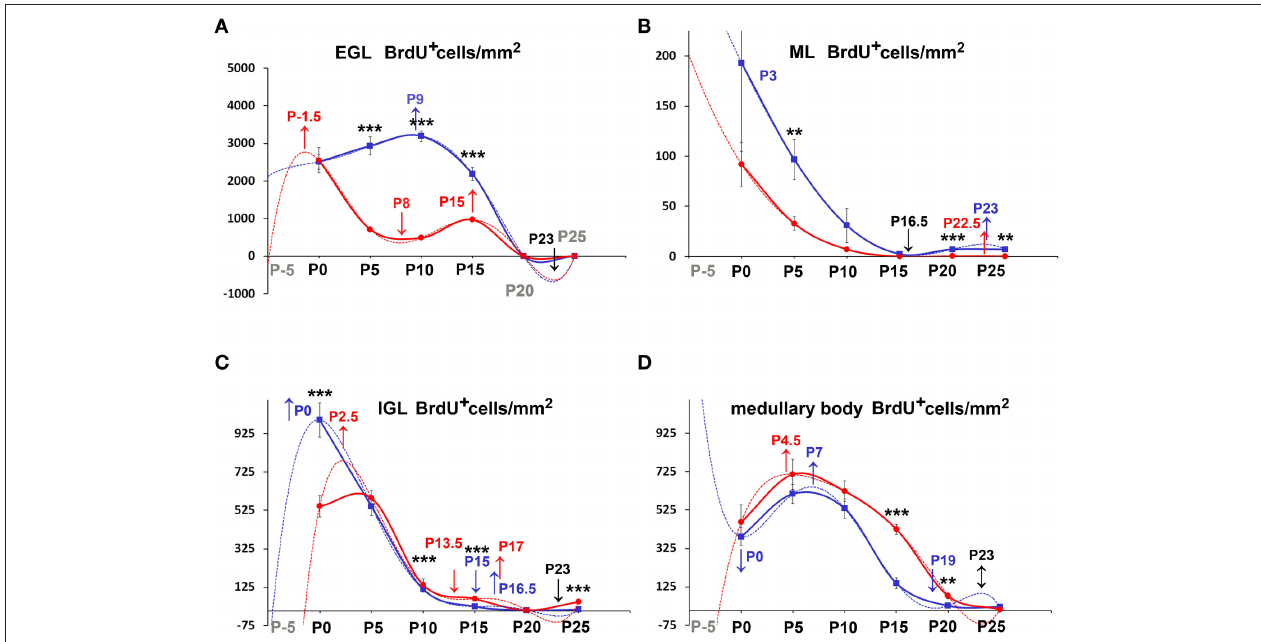
FIGURE 5 | Descriptive graphs (solid lines) and correlation curves (dashed lines) of normalized PrCDs. Graphs highlight the trends and differences across genotypes of normalized PrCD (BrdU + cells/mm 2 ) in the four cerebellar compartments defined in this study (EGL, ML, IGL, and medullary body). Postnatal ages corresponding to the minima and maxima of correlation curves are indicated with colored letters and upwards or downwards arrows. Blue and red lines or letters/arrows refer to reln + / + and to reln − / − mice, respectively. Black letters for postnatal ages and arrows indicate reference to both genotypes. Postnatal ages in gray (x axis) indicate the time points of correlation curves outside the sampling interval (extrapolations). In the EGL, there were no significant differences across the two genotypes at birth, but, in the P5–P15 interval, PrCD was lower in the mutants ( A , red lines). Note the temporal switch of the positive/negative peaks in the regression curves of proliferating cells in reln + / + (blue dashed lines) and reln − / − (red dashed lines) mice. In the ML (B) , reln + / + mice displayed higher PrCD (blue lines). Notably, reln + / + mice had a higher percentage of proliferating cells at P25 ( reln + / + 7.16 ± 0.01, reln − / − 0.25 ± 0.06, P < 0.01). Trends and related differences were more complex in the IGL (C) . PrCD was higher in reln + / + mice at birth, but reln − / − mice displayed higher values at P10, P15, and P25. Notably, in both genotypes there was a drop at P10. The percentages of BrdU + cells were higher in reln + / + mice at P0 ( reln + / + 9.07 ± 0.34, reln − / − 6.27 ± 0.36, P < 0.01), in reln − / − mice at P10 ( reln + / + 1.07 ± 0.25, reln − / − 7.12 ± 1.41, P < 0.05) and P15 ( reln + / + 0.26 ± 0.16, reln − / − 2.17 ± 0.41, P < 0.05). In the medullary body (D) , there were no differences in PrCD in the P0–P15 interval, and at P25. At P15 and P20, Reeler mice (red lines) displayed significantly higher values than reln + / + mice. There were not statistically significant differences in the percentages of BrdU + cell. EGL, external granular layer; IGL, internal granular layer; ML, molecular layer; P, postnatal age. One-way ANOVA with multiple comparisons; error bars indicate SEM; *** P < 0.001; ** P < 0.01; * P <